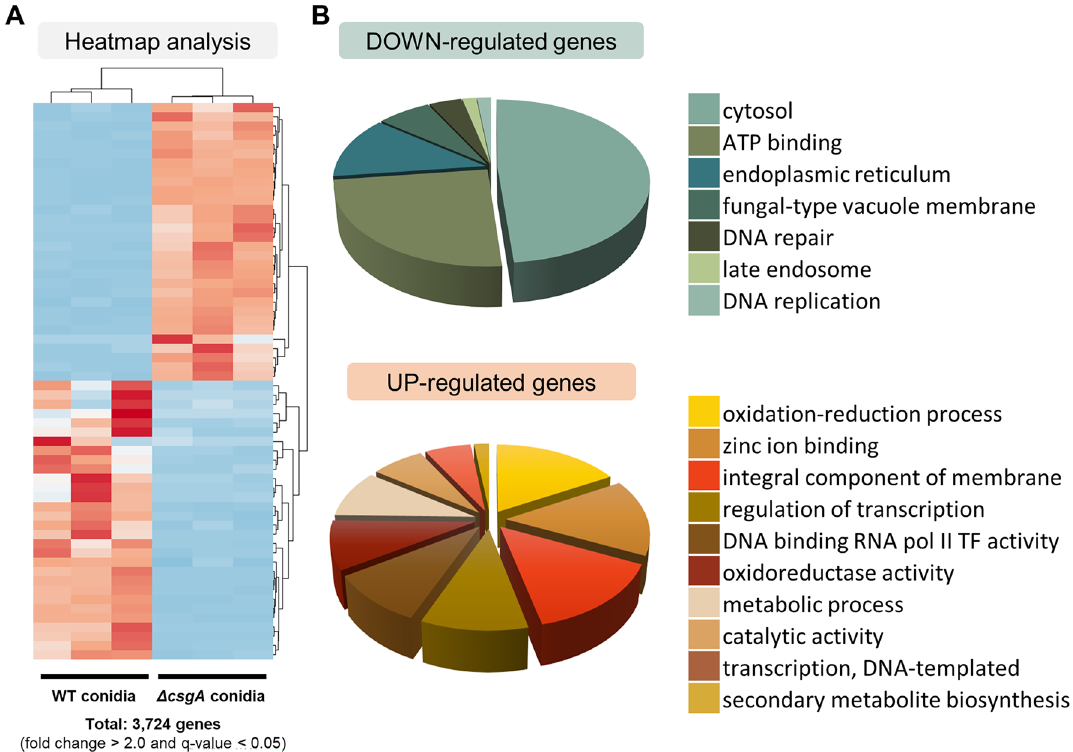
Figure 6. Transcriptomic analysis of Δ csgA conidia. ( A ) Heat map of differentially expressed genes (DEGs) between WT and Δ csgA conidia (fold change > 2.0; q-value < 0.05). ( B ) GO term enrichment analyses of down- regulated and up-regulated genes in Δ csgA